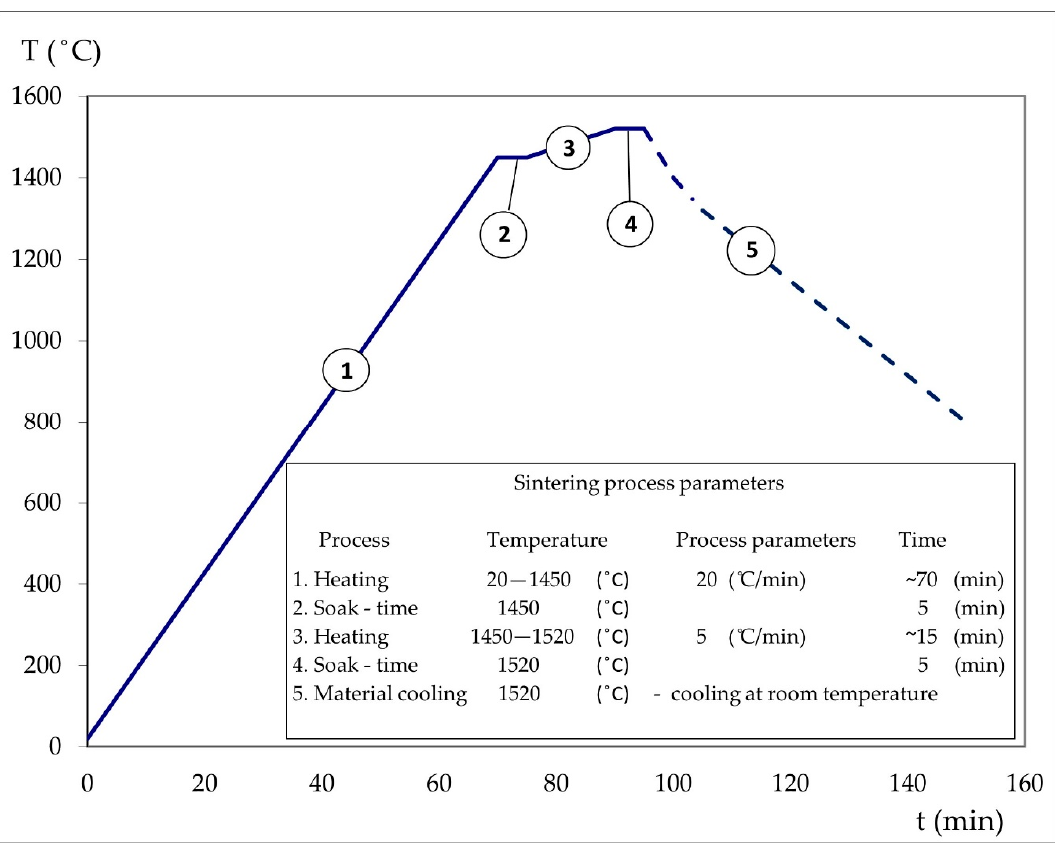
Figure 2. Join-process temperature diagram.